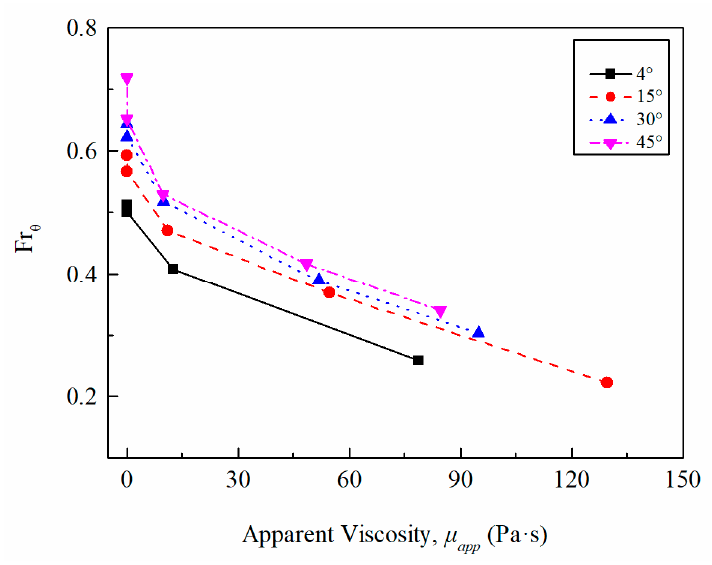
Figure 11. Influence of apparent viscosity on drift velocity (data set in Appendix